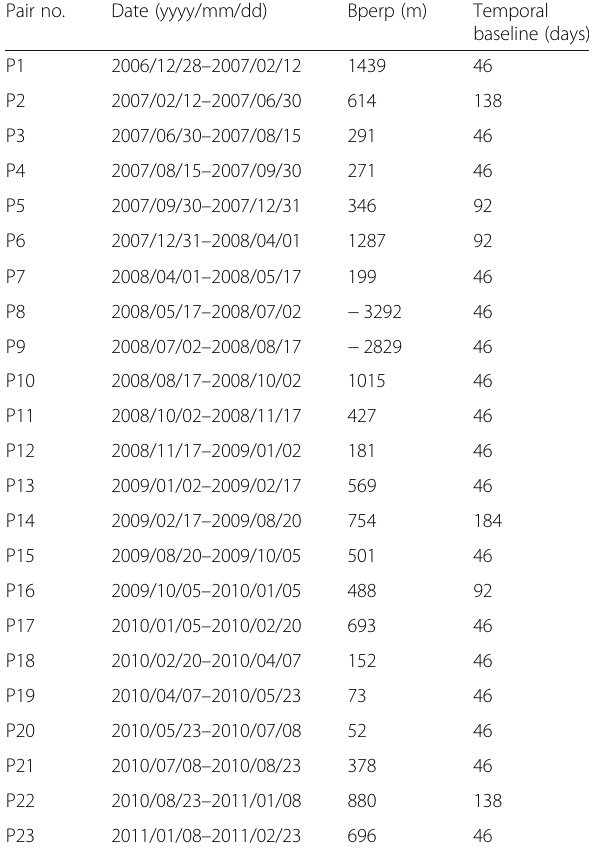
Table 1 ALOS/PALSAR datasets for interferograms in Fig. 3. All data sets are acquired from the ascending track (mostly from the south to the north) with an incidence angle 38.7° at the image center and a heading angle of − 10.1° measured clockwise from the north. The path and frame of all pairs are 573 and 800, respectively. Bperp means a perpendicular baseline Pair no. Date